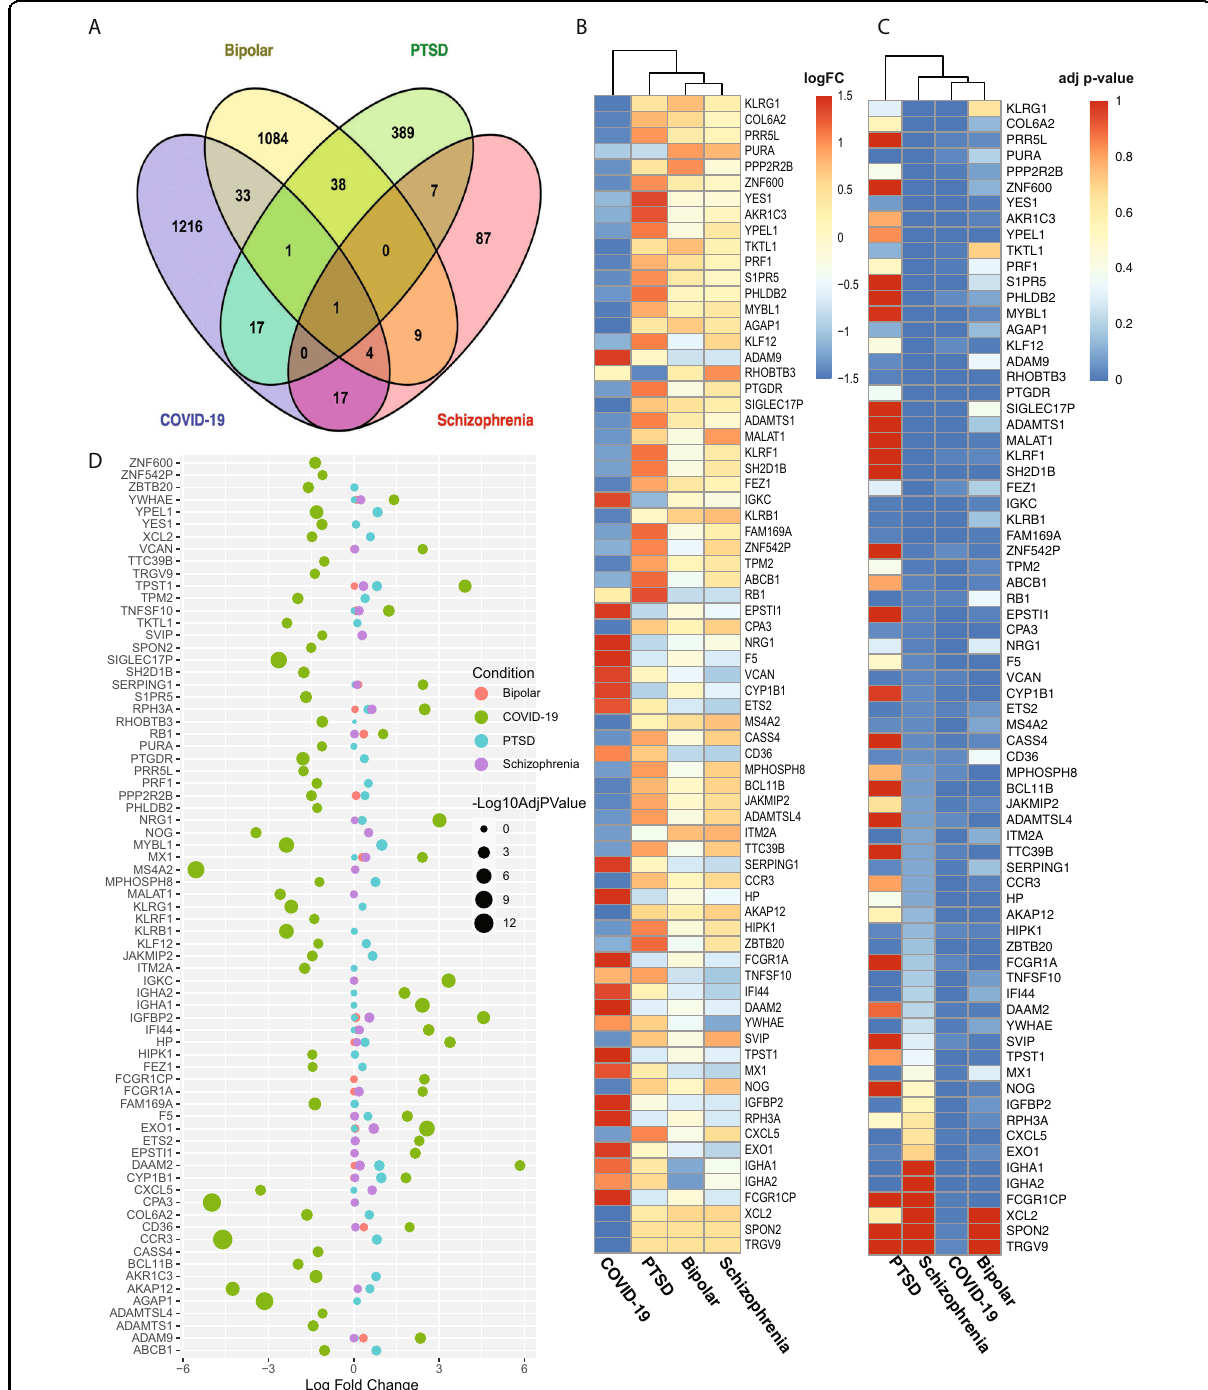
Fig. 2 Comparison of RNA-Seq analyses of SARS Cov-2 infected patient whole blood PBMC reveals shared common genes with the Bipolar disorder, PTSD and Schizophrenia PBMC transcriptomic genes. A Venn diagram shows the number of common signi fi cant genes of SARS Cov-2 with the bipolar disorder, PTSD and schizophrenia. B Heat map of the log fold changes for the shared common genes between SARS-CoV-2 and either of the bipolar disorder, PTSD and schizophrenia. C Heat map of the adjusted p-values for the shared common genes between SARS-CoV-2 and either of the bipolar disorder, PTSD and schizophrenia. D Bubble plot shows the combined log fold changes and adjusted p -values for the shared common genes between SARS-CoV-2 and either of the bipolar disorder, PTSD and